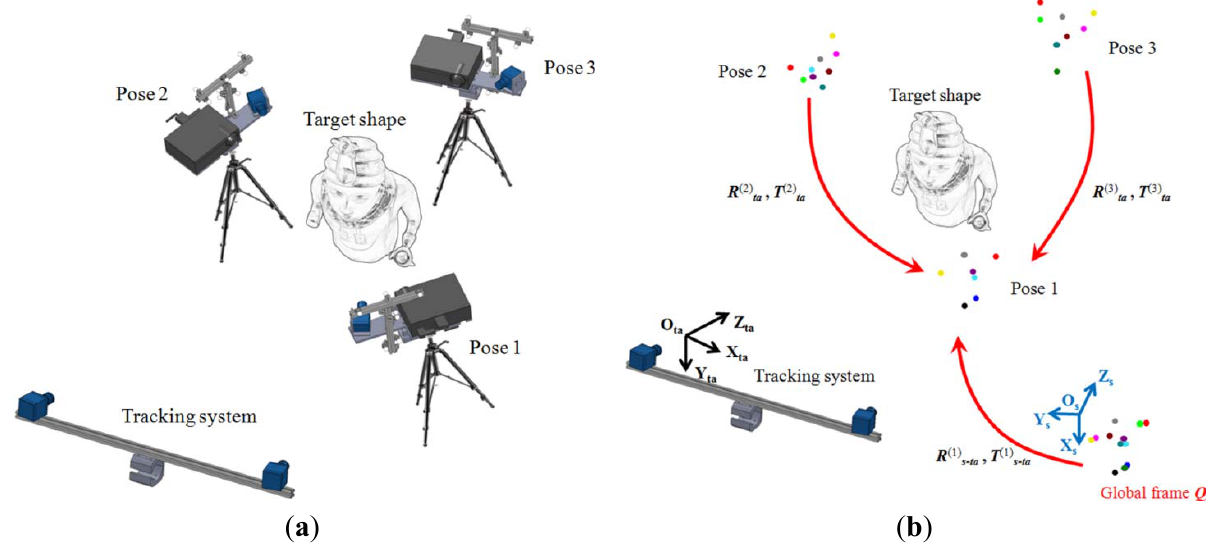
Figure 5. ( a ) Three different poses of the optical scanner during the measurement process. ( b ) Frame matching of common markers for the range maps